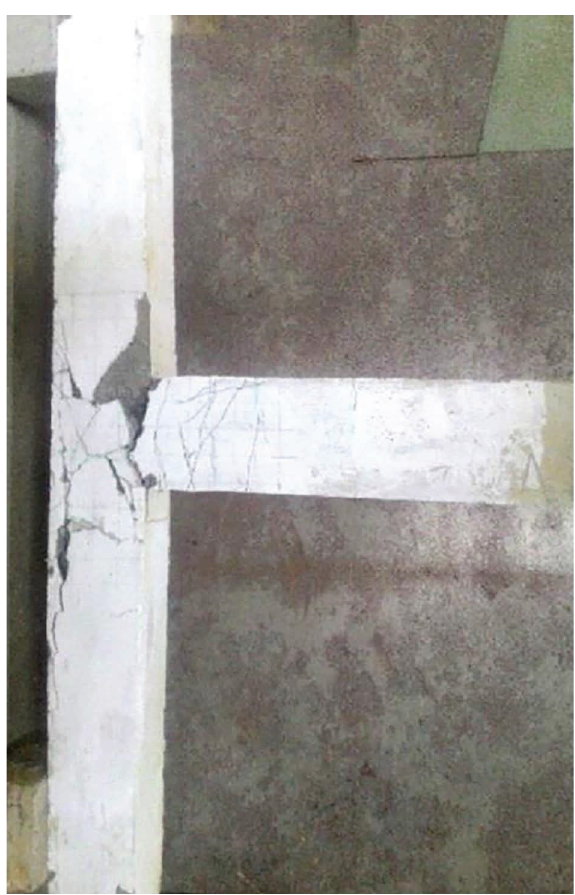
Figure 5: Fracture patterns of the control